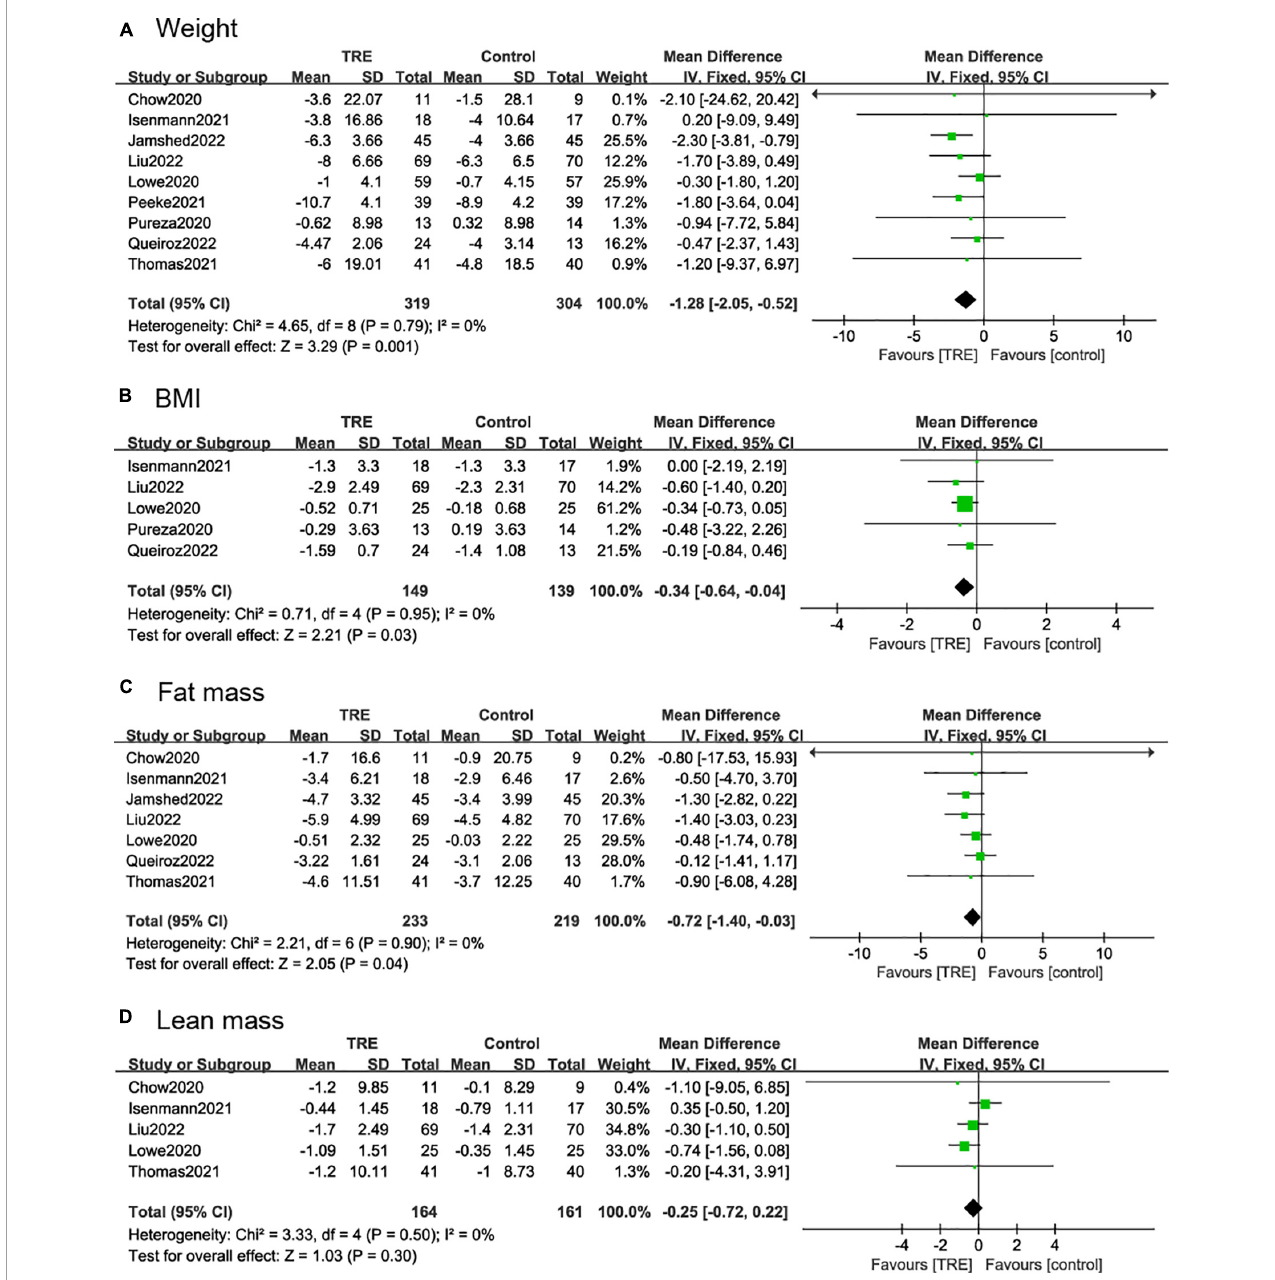
FIGURE4 Forest plots of comparisons between TRE and the control groups in (A) weight; (B) body mass index (BMI); (C) fat mass; and (D) lean